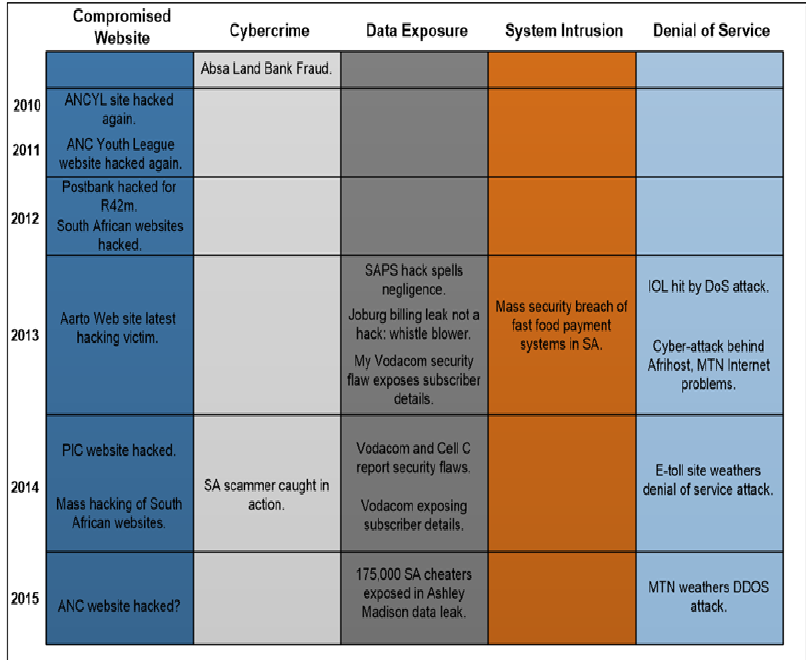
Figure 2: Classification of cyber incidents by type, 2010 – 2015 (21